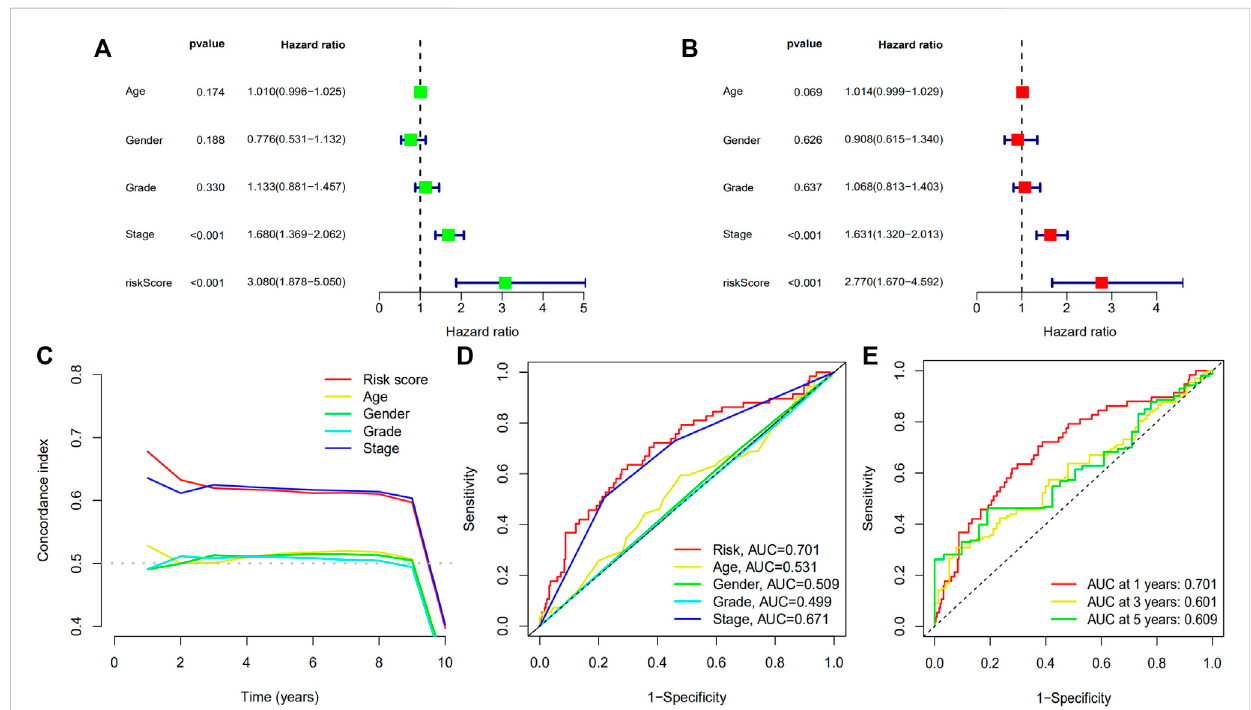
FIGURE 9 Forestplotsofunivariateprognosticanalysisforriskscore (A) andmultivariateprognosticanalysis (B) ,andconcordanceindex (C) andROCcurve (D) of different variables, and ROC curve (E) of prognostic model. (ROC: receiver operating characteristic).